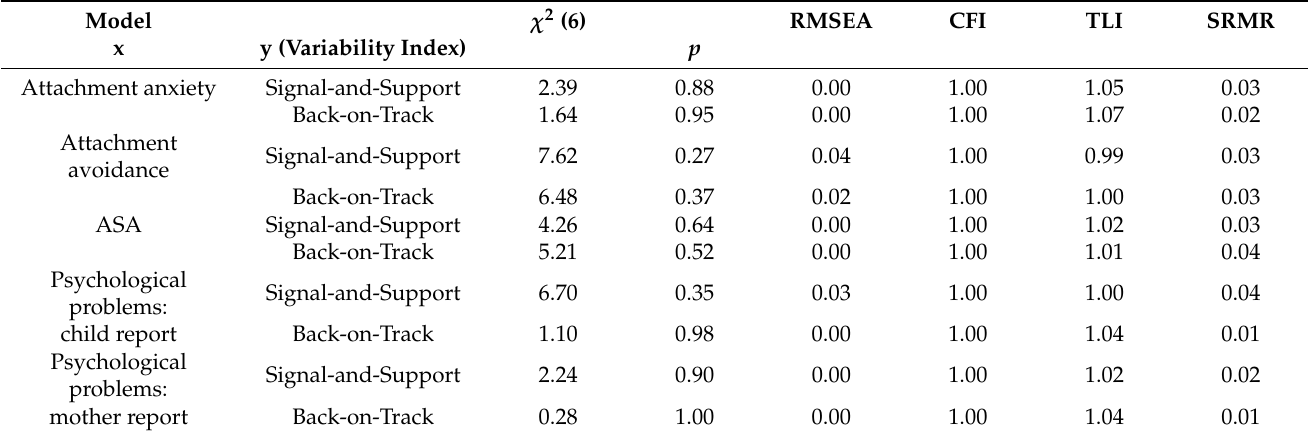
Table 4. Model fit indices for RI-CLPMs with constrained within-level parameters.